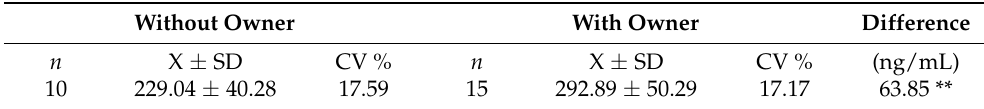
Table 2. Serotonin levels in dogs without or with owner (ng/mL). Without